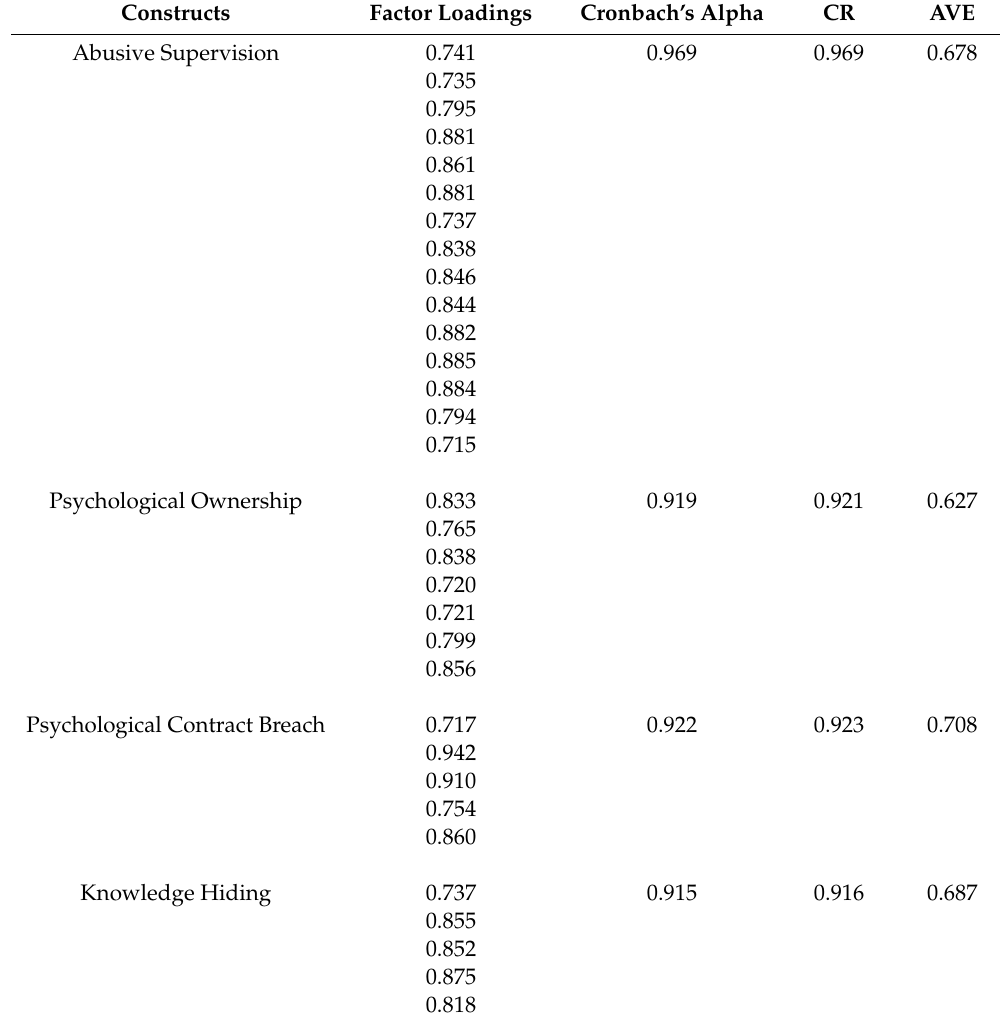
Table 2. Assessment of the measurement model.